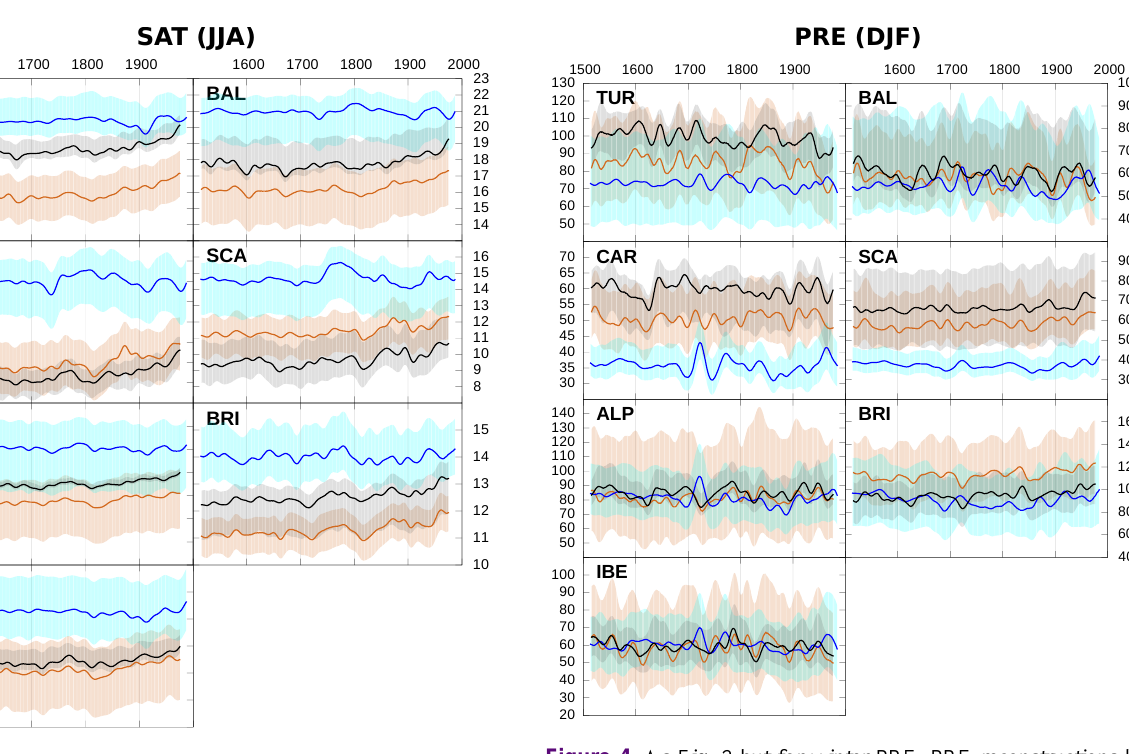
(Fig. 4 and 5). Variability also appears to change over time.